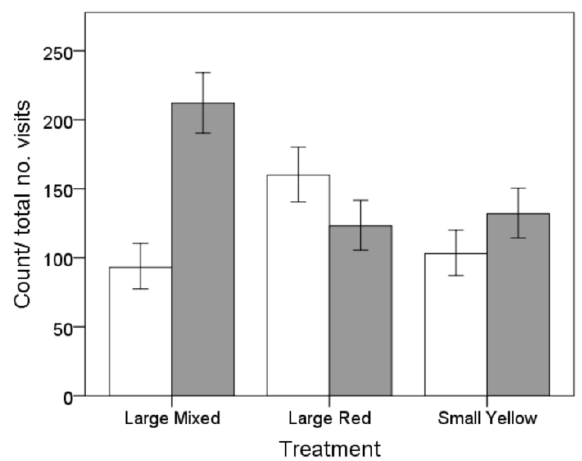
F IGURE 4. Total number (95% CI) of single (white bars)/multiple (grey bars) visits to inflorescences by study species. Highest number of multiple visits by butterflies occurred at Large Mixed inflorescence whereas, highest number of single visits occurred at Large Red